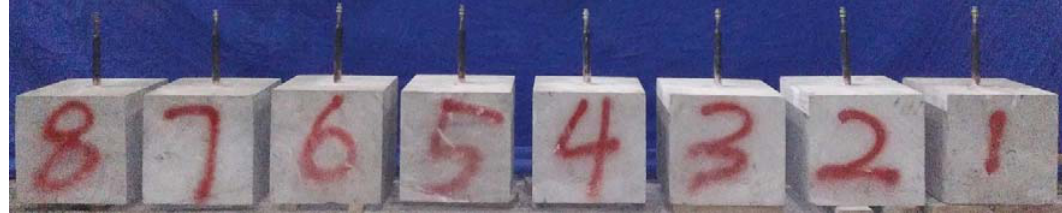
Figure 8. Completed sandstone specimens ready for hydraulic fracturing testing.